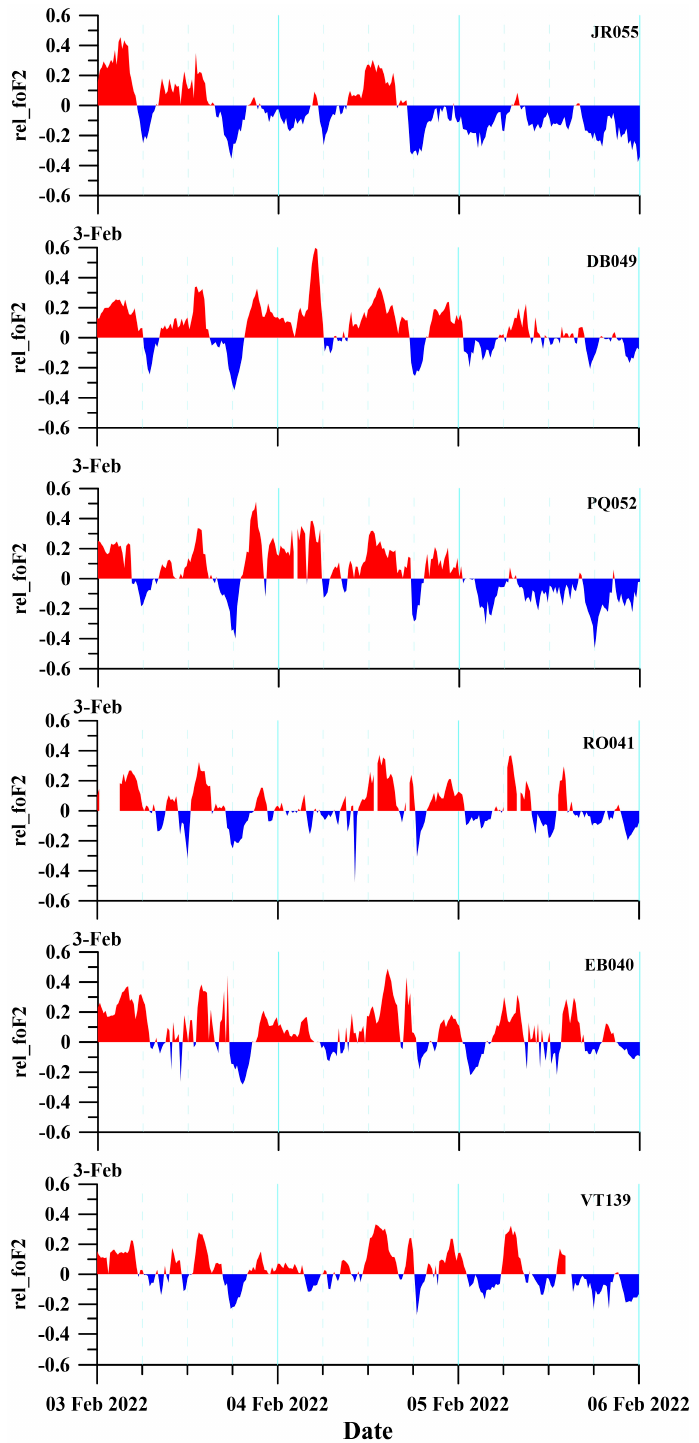
Figure 5. Ionospheric response to storms on 3 − 5 February 2022, represented by individual ionospheric stations.